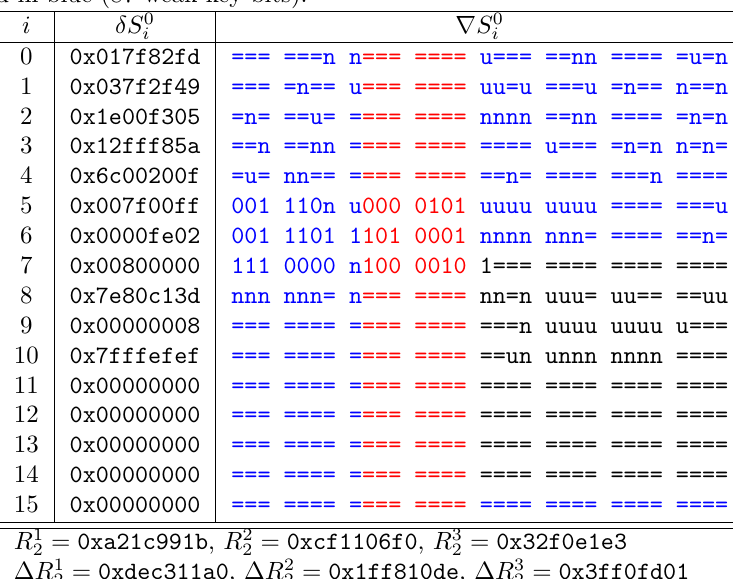
Table 3: The input difference for the attack on 30-round ZUC-256-v2 , where the positions to set constants in the loading scheme are marked in red and the positions to set key bits are marked in blue (87 weak key